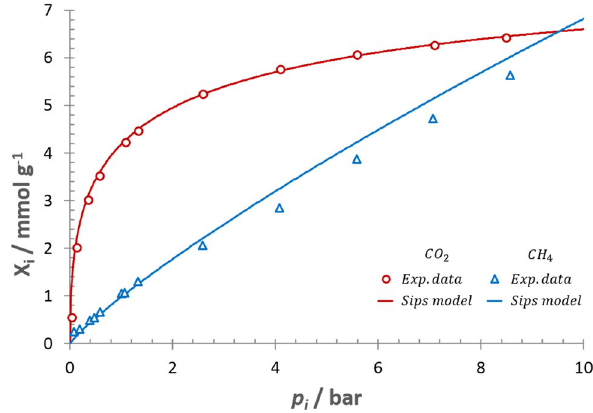
Fig. 7 Adsorption equilibria of Ni-MOF-74@Al and CH (blue) at T = 303.15 K approximated by the Sips isotherm Fig. 8 Time dependent adsorption uptake response induced by a 4